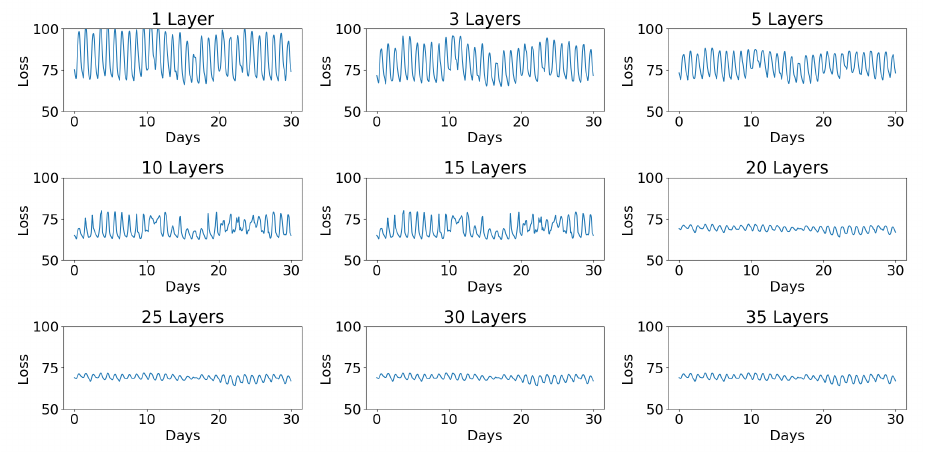
Figure 10. How different numbers of layers in a GRU-AE affect the ability to model environmental data. The smaller the standard deviation, the better the model